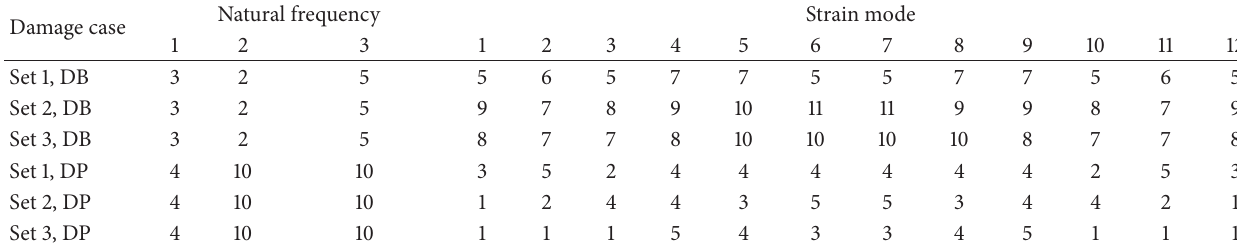
Table 6: Sections of each attribute set and condition attributes.